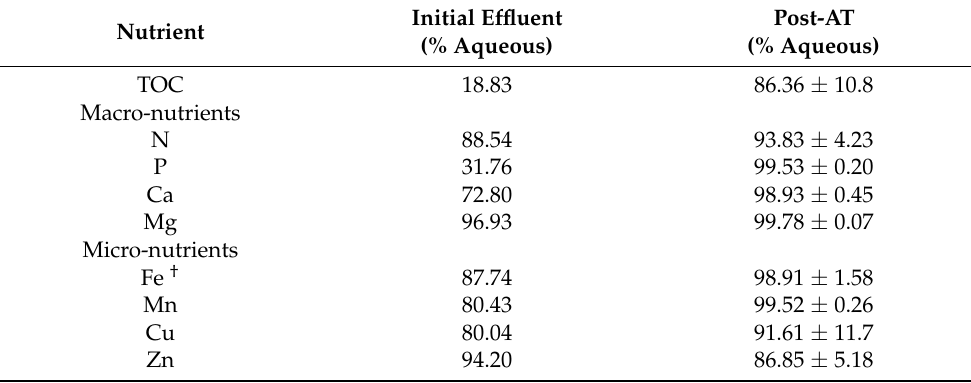
Table 4. AT reactor nutrient analysis. Percent change of nutrient concentrations in aqueous form (plant available) in the aquaponic tilapia effluent after AT. Mean percent ± SD of total nutrients in aqueous form before and after anaerobic treatment are shown.